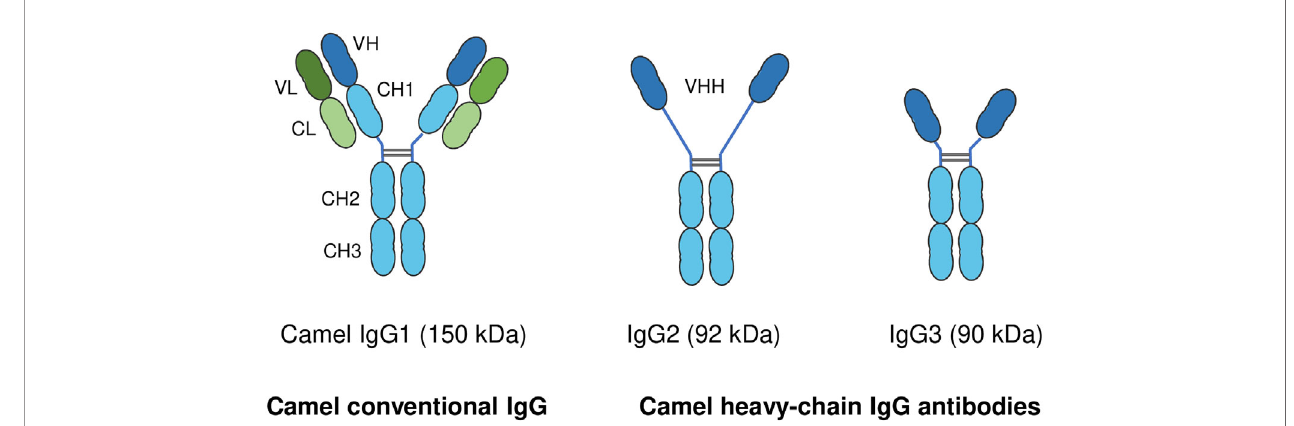
FIGURE 3 | Structure of camel immunoglobulin (Ig) G subclasses. Camel IgGs are currently classi fi ed into three structurally different isotypes: Camel IgG1 consists of two identical heavy chains (H) each composed of three constant domains (CH1 – CH3) and a single variable domain (VH). Each heavy chain is covalently bound to identical light chains (L) with a constant (CL) and a variable domain (VL). Camel IgG2 and IgG3 are composed of only two identical heavy chains (long-hinge heavy chain in IgG2 and short-hinge heavy chain in IgG3). Camel single-chain IgG subclasses are devoid of the fi rst heavy chain constant region CH1.